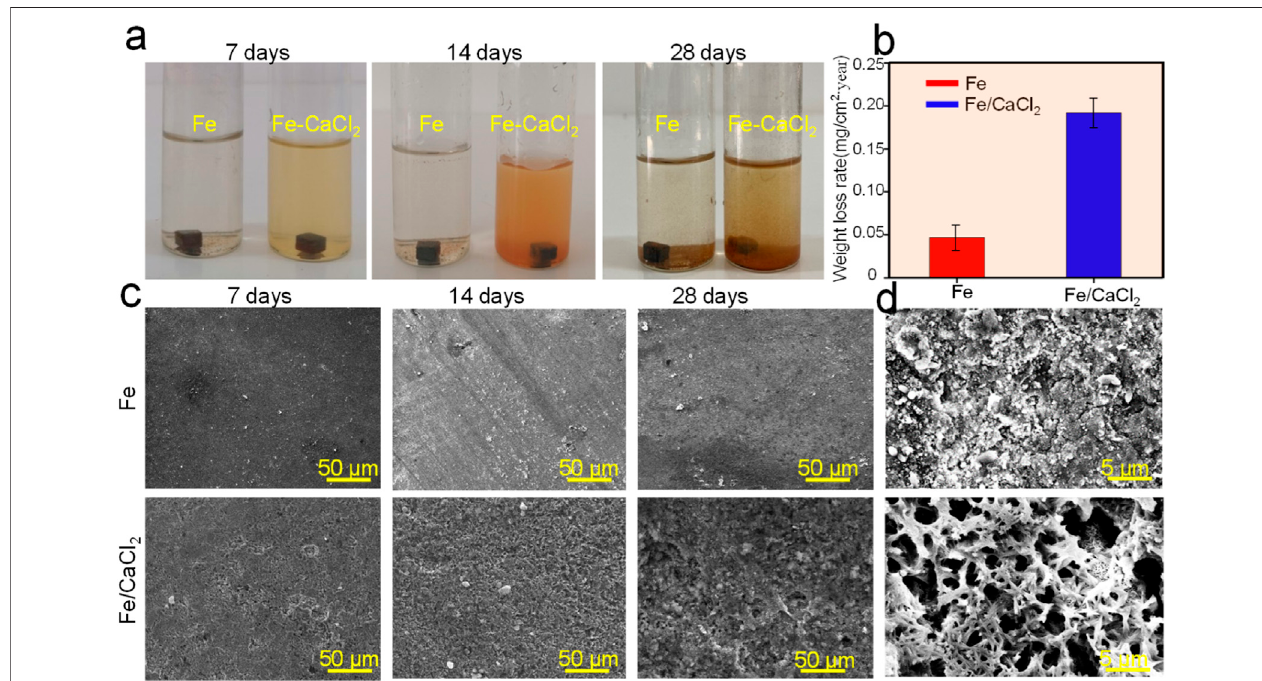
FIGURE 3 | (A) The photograph showing the samples immersed in SBF for 7, 14, and 28 days, (B) the weight loss rate, (C) the corresponding typical corrosion morphology, and (D) enlarged view of the corrosion